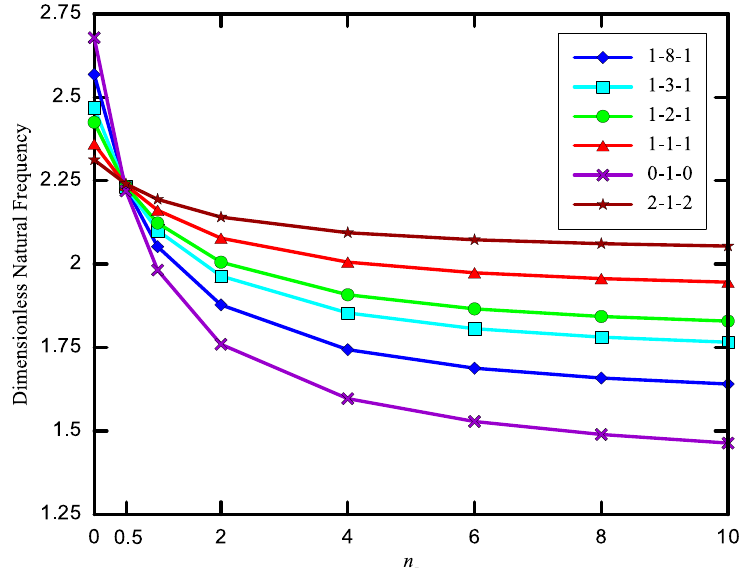
Fig. 9. Variation non-dimensional natural frequency 𝝎̅ with n z for (CCCC) Plate with n x =